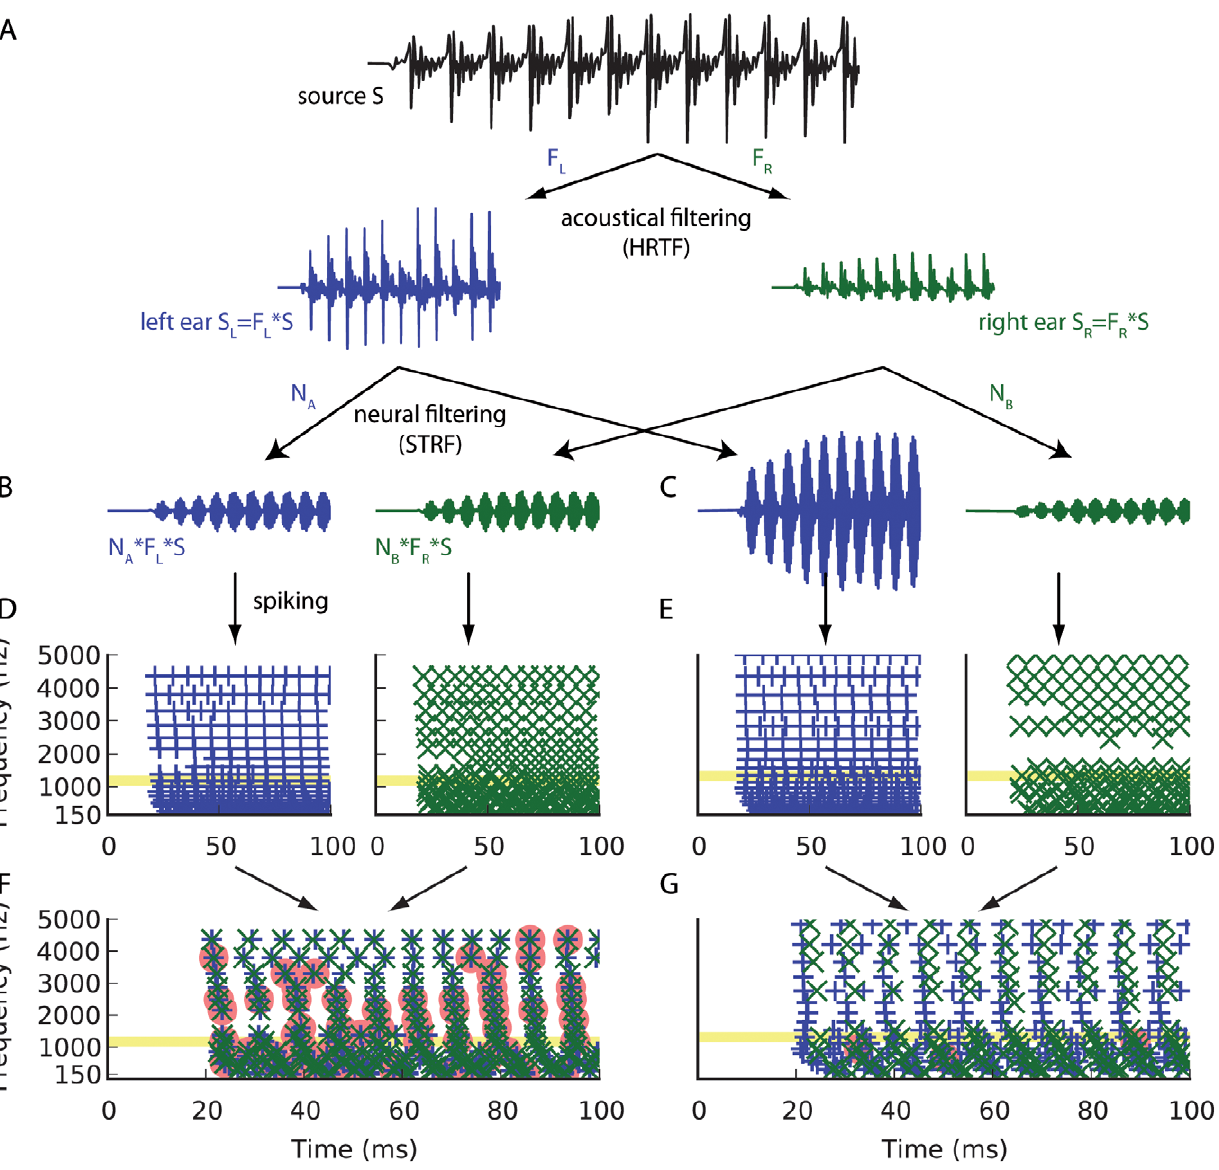
Figure 1. Synchrony patterns induced by location-dependent filtering. The left hand panels (A, B, D, F) show the signal pathway for a set of neurons tuned to the presented location of the sound, and the right hand panels (A, C, E, G) show the pathway for neurons not tuned to the presented location. (A) The sound source S propagates to the left ear (blue) and right ear (green) and is acoustically filtered by location-dependent HRTFs. (B, C) Signals resulting from filtering through the spectro-temporal receptive fields of two pairs of monaural neurons tuned at 1 kHz. The source location is in the synchrony receptive field of the first neuron pair (B). (D, E) Spike trains produced after neural filtering, for neurons tuned at frequencies between 150 Hz and 5 kHz. The signals shown in B and C correspond to the spike trains highlighted in yellow. The source location is in the synchrony receptive field of each frequency-specific neuron pair in panel D but not in panel E. (F, G) Spike trains from the left and right channels are reproduced here superimposed. Postsynaptic neurons that receive coincident inputs from their two presynaptic neurons produce spikes (red patches). The neural assembly in F is tuned to the presented location whereas the assembly in G is not.